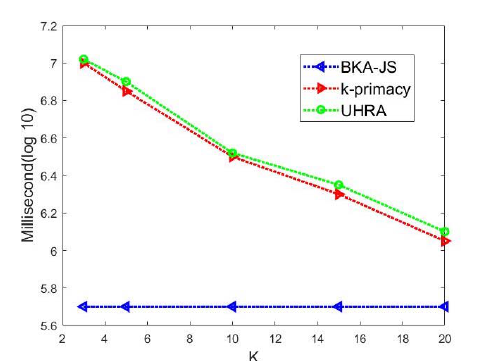
Figure 5. Execution time (in milliseconds with log 10 scale) of our algorithm when J = 0.8, t = 0.5, and the k value varies on the BKseq